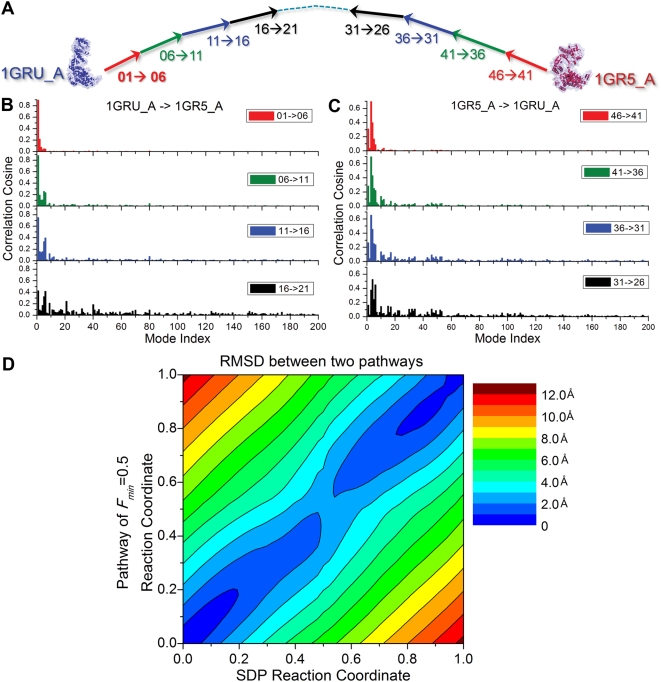
Comparison with the results from steepest descent pathway (SDP)
based on action minimization.(A) Fragmentation of the SDP pathway for the transition
1GRU←→1GR5 of a subunit into nine macrosteps,
consisting each of five frames. Same color scheme is adopted in
panels B and C. (B) Correlation between SDP macrosteps and ANM modes
accessible to the original conformation . (C) Same as panel B, for the right portion of the
trajectory, i.e. the reconfiguration from 1GR5_A to 1GRU_A using the
eigenvectors  generated for 1GRU_A. Note that the early
macrosteps from both directions are accounted for by a few slowest
ANM modes, while increasingly higher modes are being recruited as
the molecule proceeds away from its original conformation,
consistent with the results found by aANM (see
Table 1).
(D) RMSD values between the intermediate conformations sampled by
the aANM and SDP methods. The aANM
results refer to the trajectory
Fmin = 0.5.
The RMSDs between pairs of intermediates remain lower than 2.0
Å at all steps (see the color-coded scale on the
right).